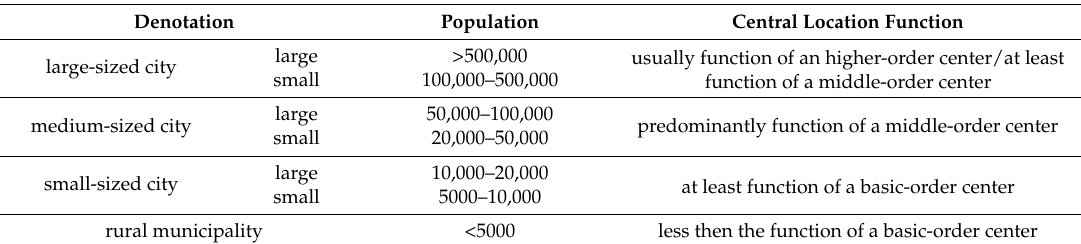
Figure 2. City and municipal types in the area of the traffic network metropolitan area of Nuremberg (Update 31 December 2017: District Hassberge is not included due to missing data) (own depiction based on [15,16,31]). Table 1. Differentiated city and municipal types [16].